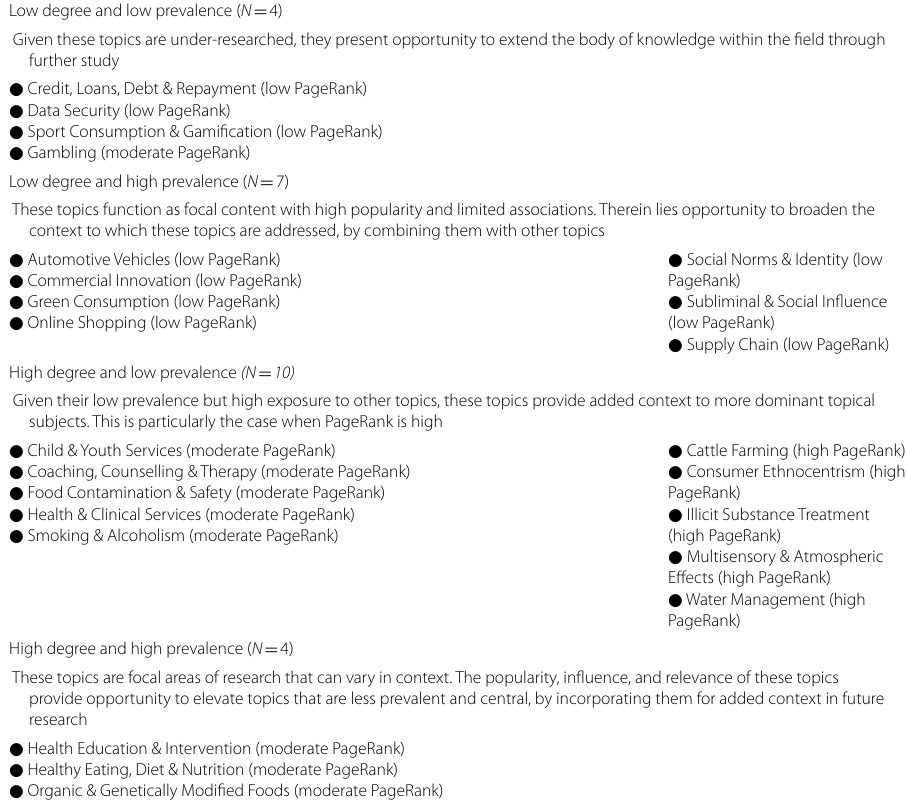
Table 4 Topic Categorization based on Distinct Prevalence and Centrality Low degree and low prevalence ( N =